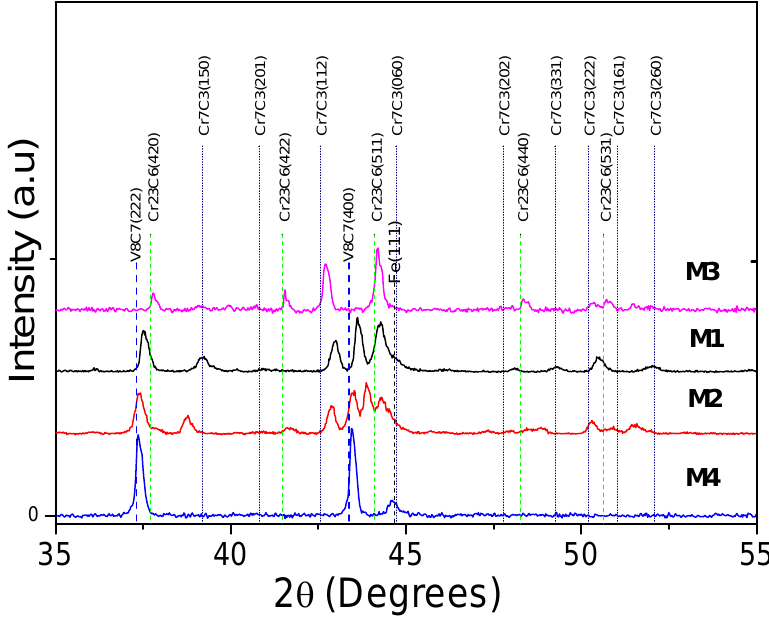
Figure 3. XRD patterns of different carbides.